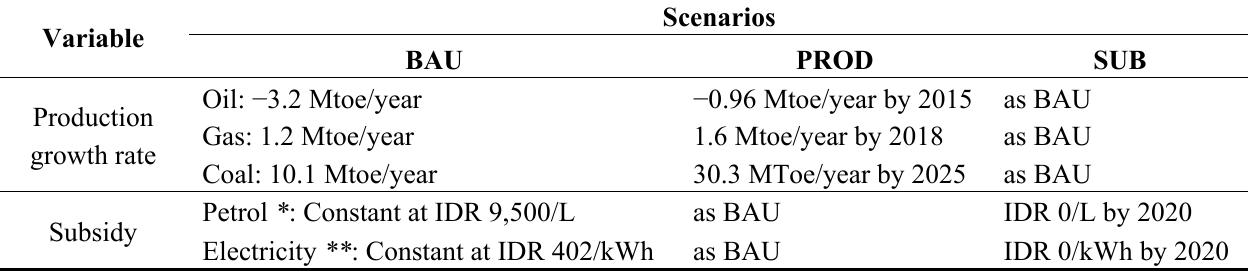
Table 5. Scenarios for